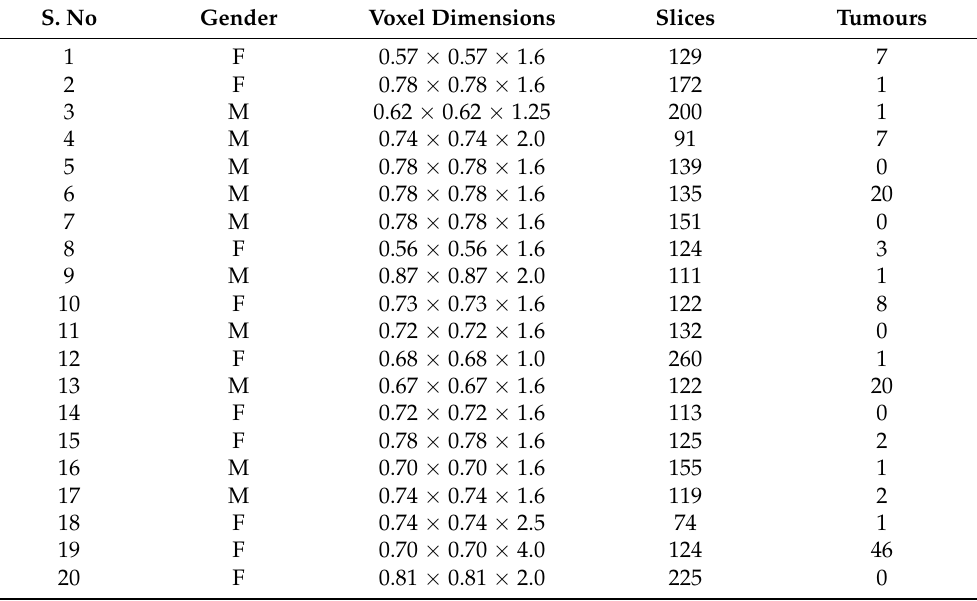
Table 1. Detailed info of 3Dircadb. (F: Female; M: Male). S.